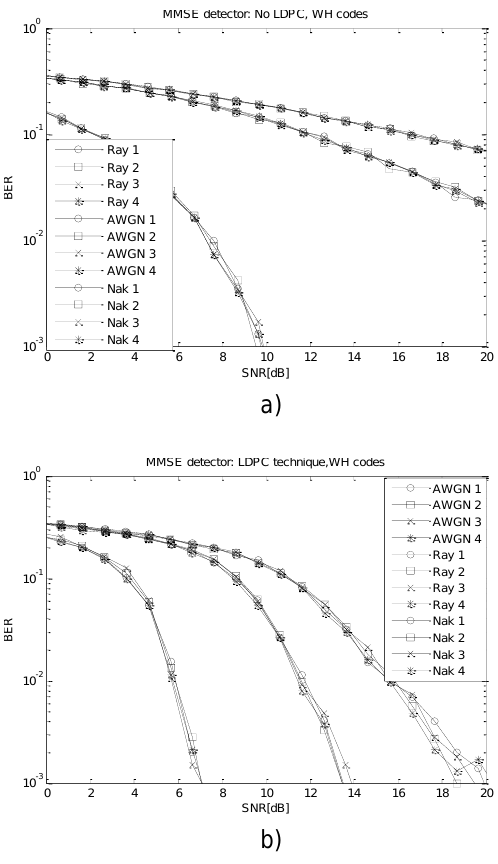
Figure 2 – BER vs SNR: Walsh-Hadamard codes (a) No LDPC (b) LDPC